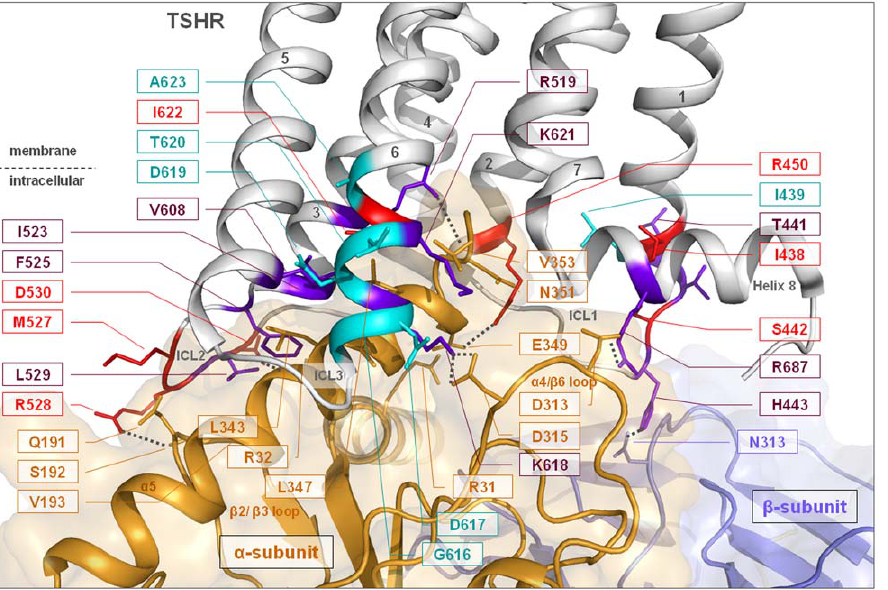
Figure 3. Homology complex model of the TSHR/Gq heterotrimer with focus on the interface between helix 8 and the transition of ICL3/transmembrane helix 6 with G a q. Our new and recently published data of intracellular key-players for the TSHR and G-protein interaction are summarized and mapped on to the 3D complex model. Several mutations in the intracellular region of the TSHR are known to prevent Gs and Gq signaling simultaneously. All mutants show decreased cAMP production by TSH in conjunction with decreased activation of the IP pathway. The following wild type amino acids should therefore be considered as commonly sensitive for regulation of the receptor/G-protein interplay: ICL1 - I438, S442, R450; ICL2 - M527, R528, D530; ICL3/TMH6 - I622. Colour codes: purple - selectively impaired Gq activation by mutation; red - inactivating mutants for Gs and Gq coupling and cyan - known constitutively activating mutants. Dashed lines indicate potential H-bonds.